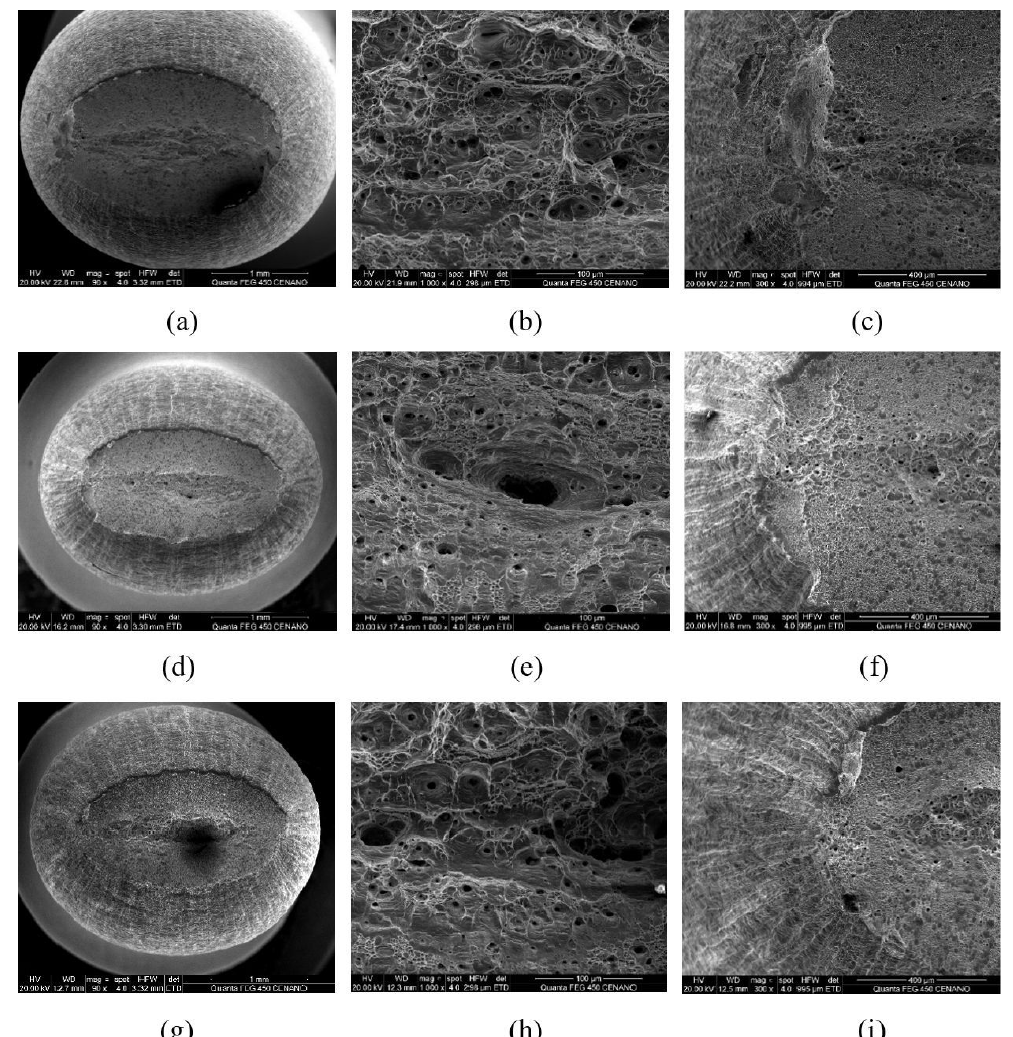
Figure 7. Fractography observed by SEM of tensile specimens: (a), (b) and (c) AR-CW(B); (d), (e) and (f) ST-1050(B); (g), (h) and (i)